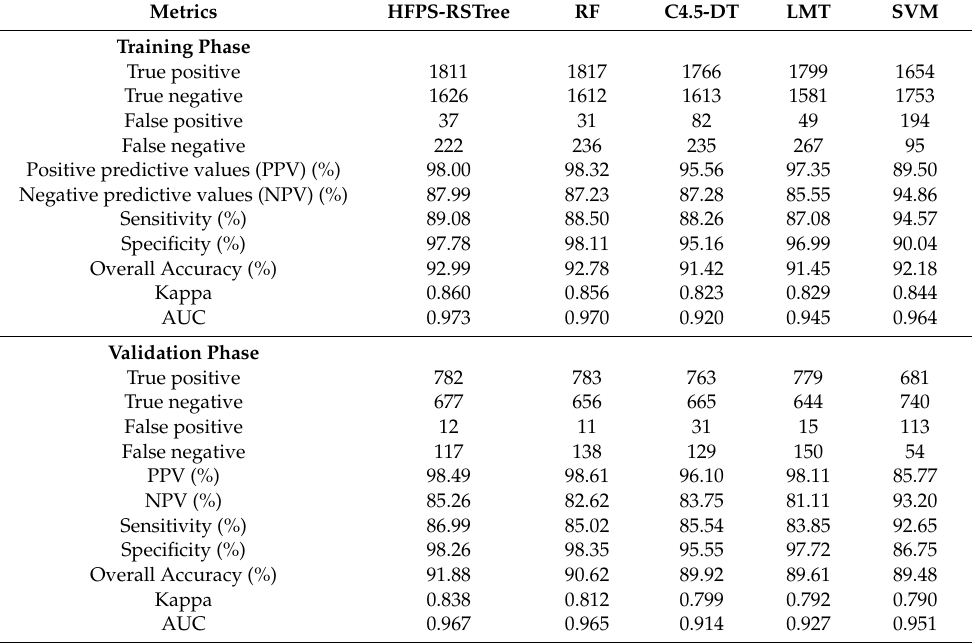
Table 3. Comparison of the HFPS-RSTree, the RF, the C4.5-DT, the LMT, and the SVM for the flash flood